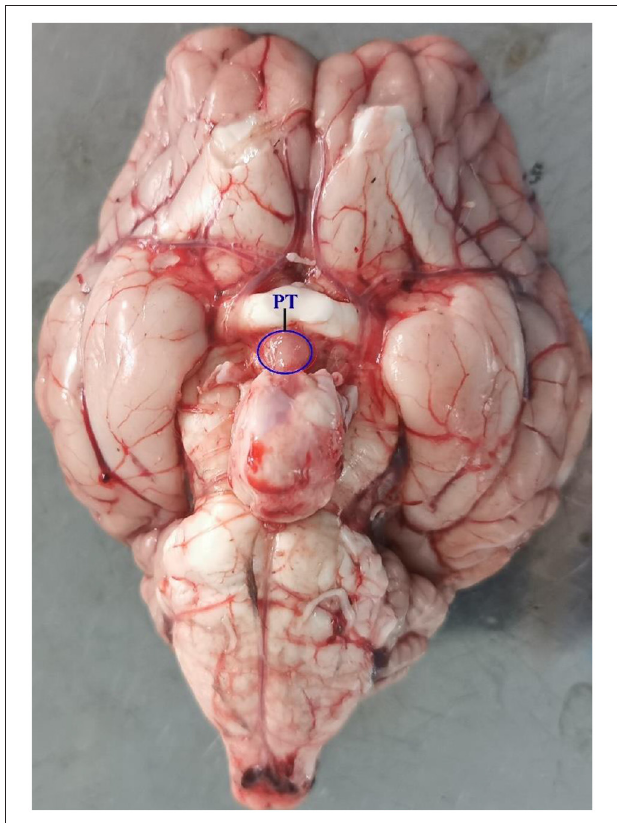
FIGURE 1 | The location of PT tissue in Sunite